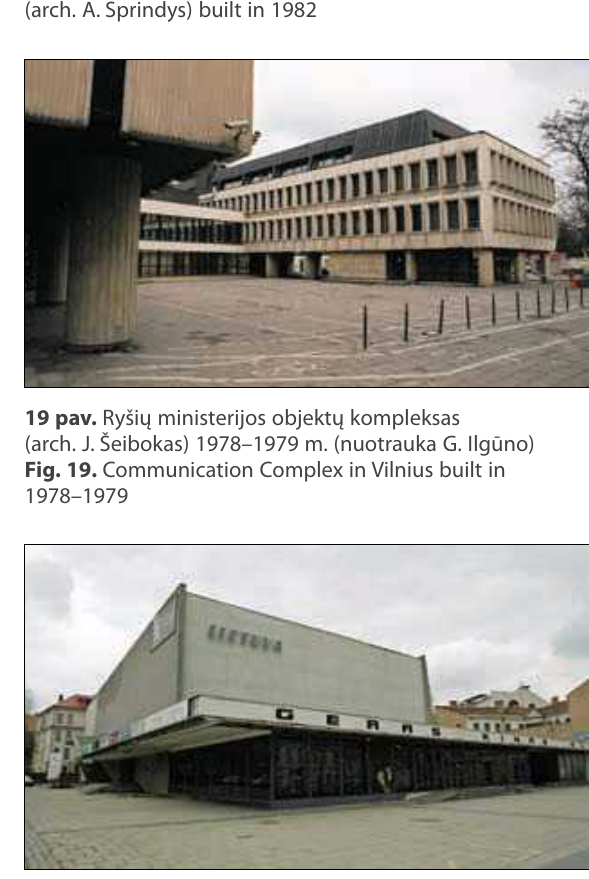
Fig. 18. commissary “Merku­riju­s“ in kau­nas